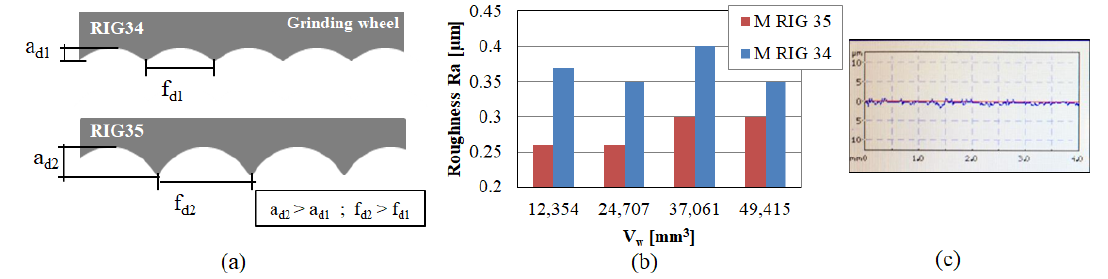
Figure 11. ( a ) Influence of sharpness ratio and the shape of the rotary dresser on the wheel surface, ( b ) roughness of workpiece after grinding and ( c ) the real Ra profile corresponding to 0.26 µm.